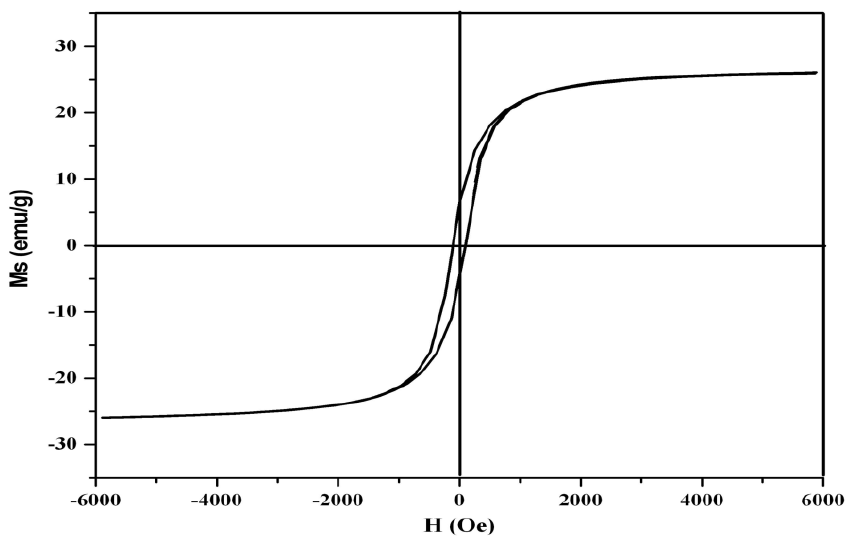
Figure 6. Hysteresis loop of synthesized magnetite nanoparticles using [BMIM][TfO] ionic liquid at room